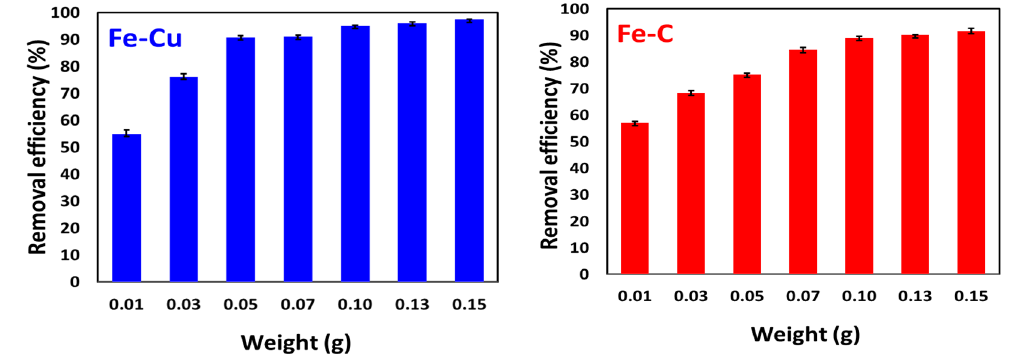
Figure 4. Effect of material mass on CIP removal under Fe-Cu and Fe-C treatment.